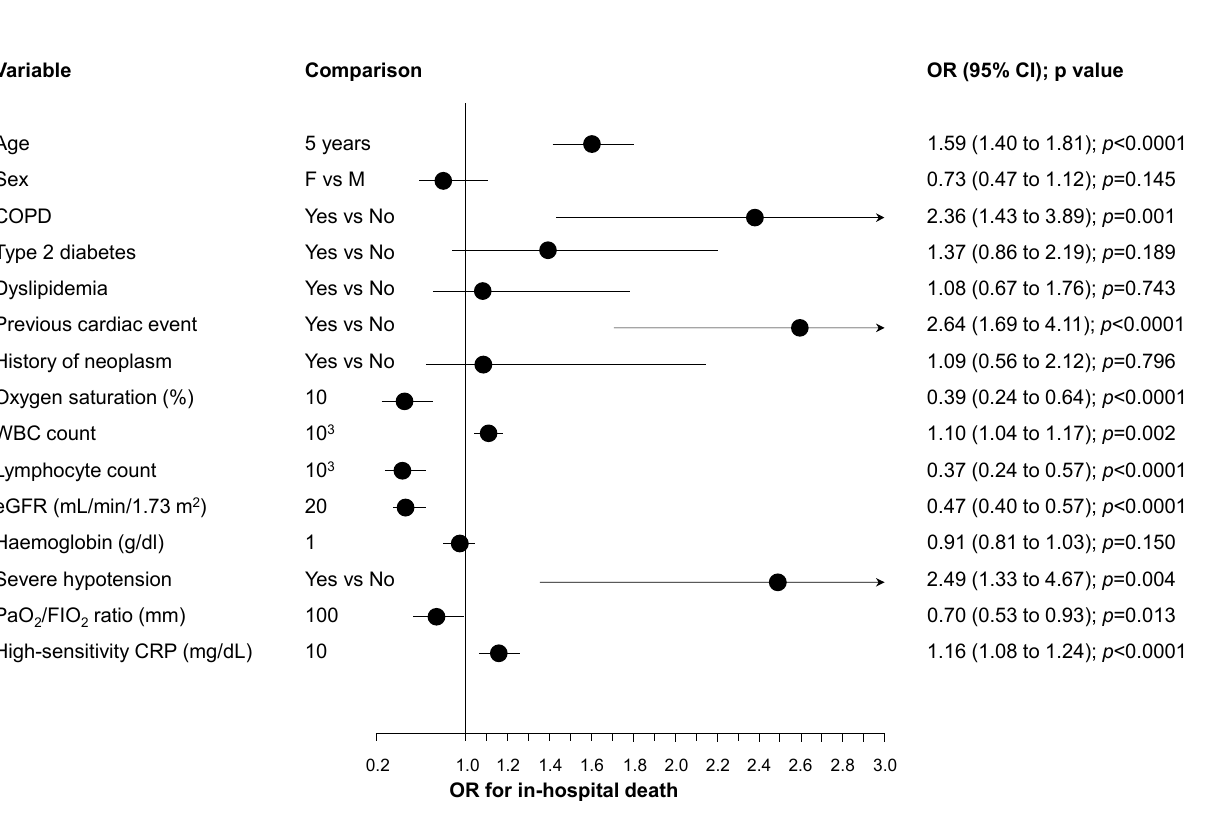
Figure 2. Results of univariable analyses exploring predictors of in-hospital death. Legend: COPD = chronic obstructive pulmonary disease; CRP = C-reactive protein; eGFR = estimated glomerular filtration rate using the Chronic Kidney Disease Epidemiology Collaboration (CKD-EPI) equation; WBC = white blood cell.